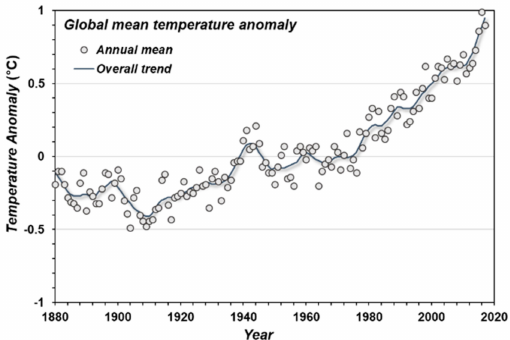
Figure 2. Global mean temperature pattern from 1880 to 2017. Reproduced with permission from the Jet Propulsion Laboratory (JPL), Global land-ocean temperature index (https: // climate.nasa.gov / vital-signs / global-temperature); published by the National Aeronautics and Space Administration (NASA)